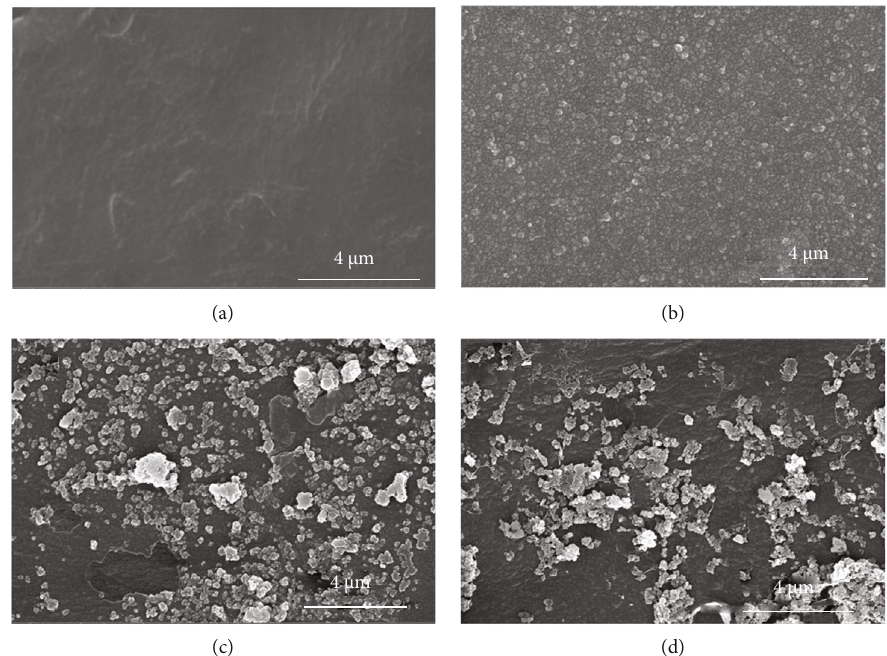
Figure 7: SEM images of typical membranes. (a) PAN substrate membrane, (b) NF-Ag-0, (c) NF-Ag-3, and (d) NF-Ag-5.